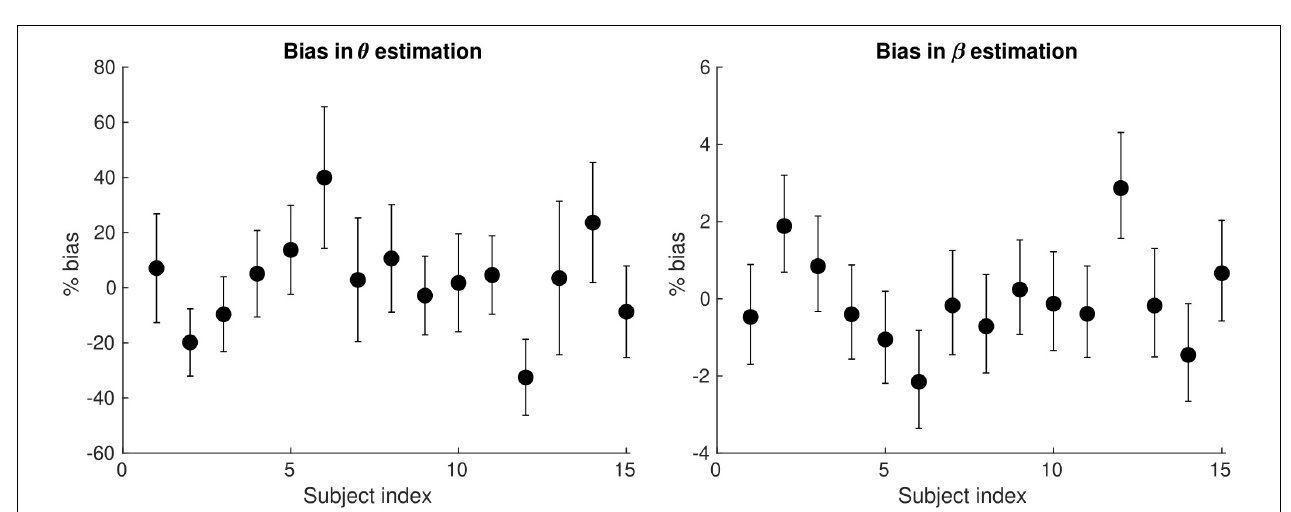
FIGURE 6 | Bias of the θ (left) and the β (right) parameter estimates arising from the computation of axonal conduction velocity across a group of subjects ( N = 15). The error bars indicate the standard deviation on the parameter estimates. The bias of θ and β reaches up to 40 and 3%,